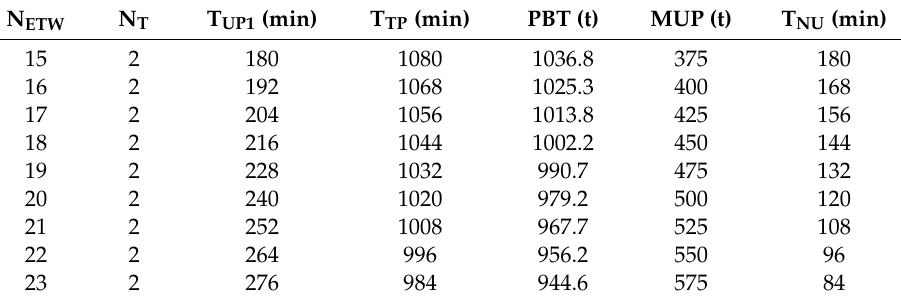
Table 6. Results for the second iteration E = 0.84 and Q = 854